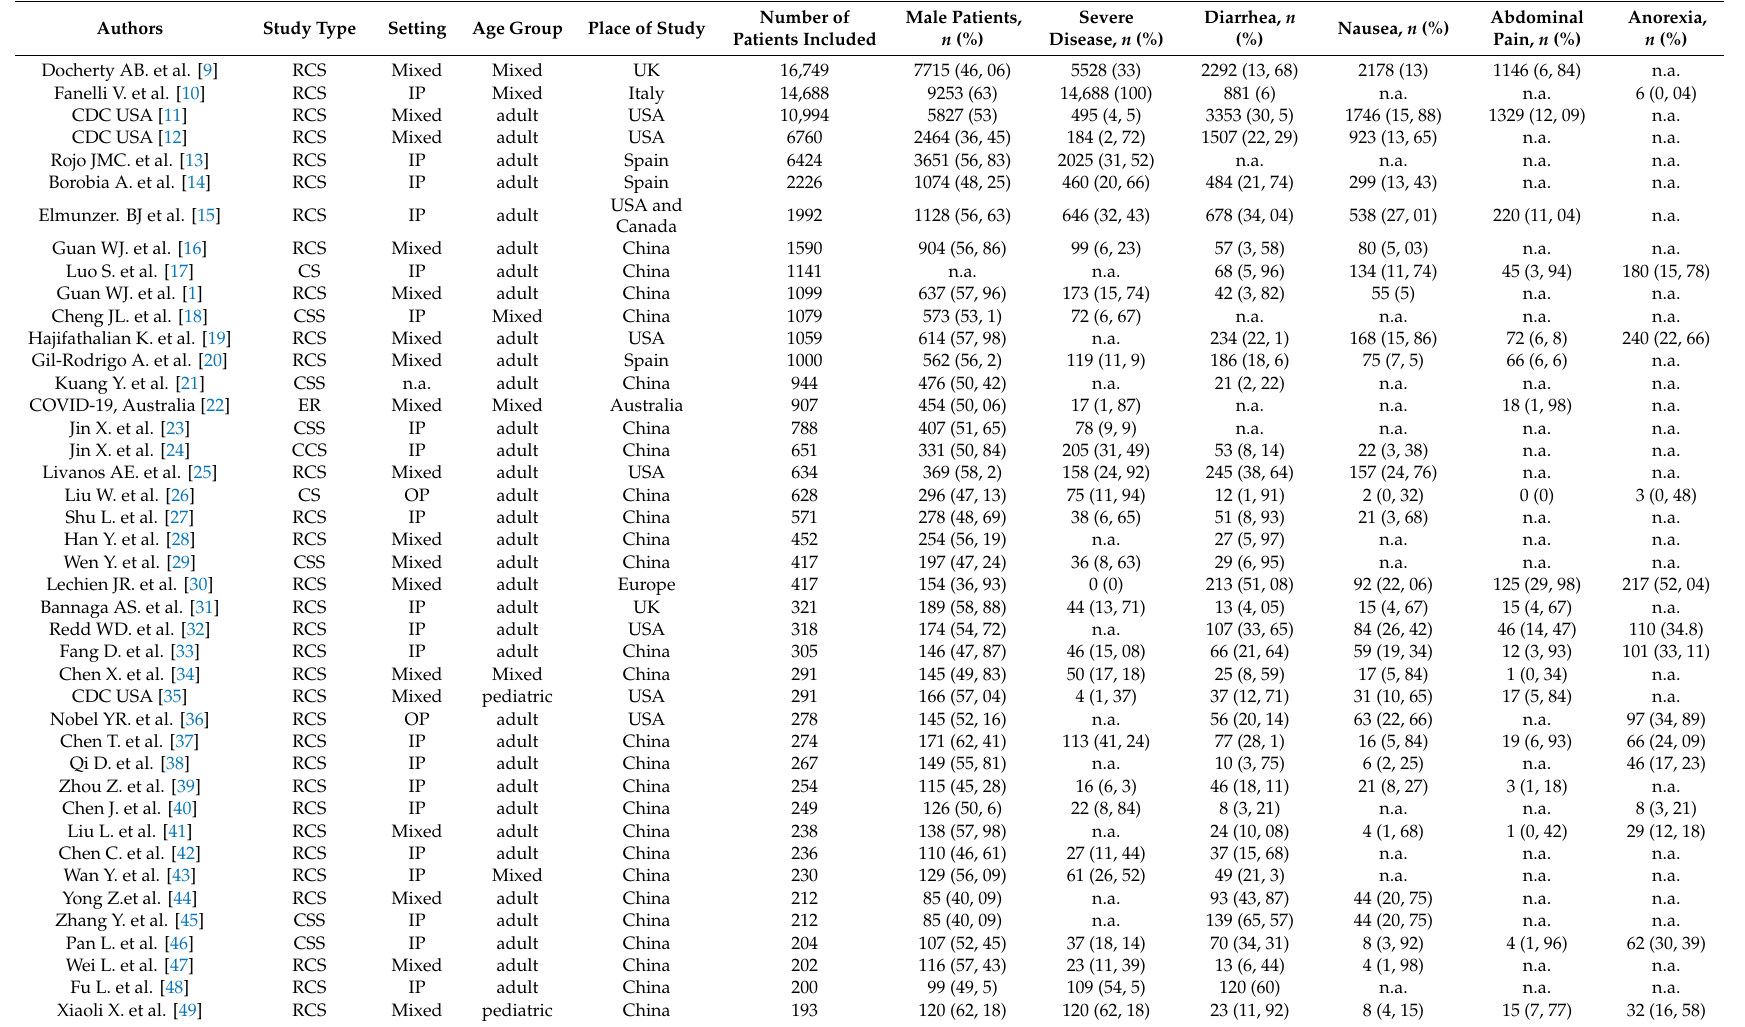
Table 1. Characteristics of the studies included in the systematic review and